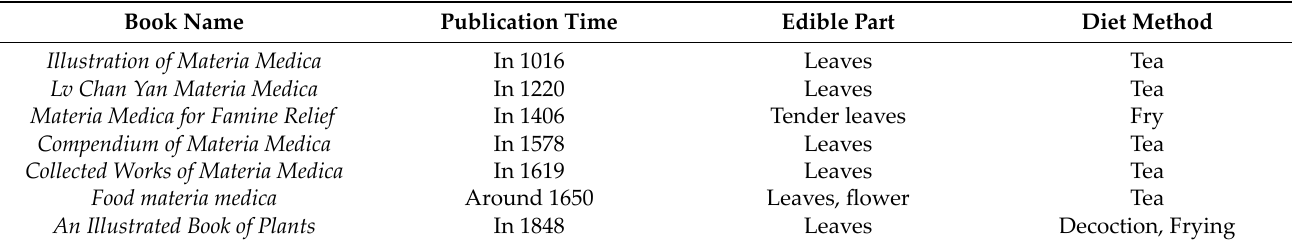
Table 1. Traditional meal usage of